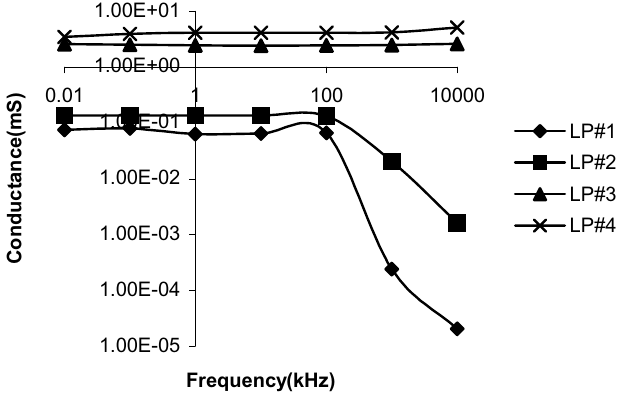
Figure 3. The variation of conductance against frequency for the In at low vacuum